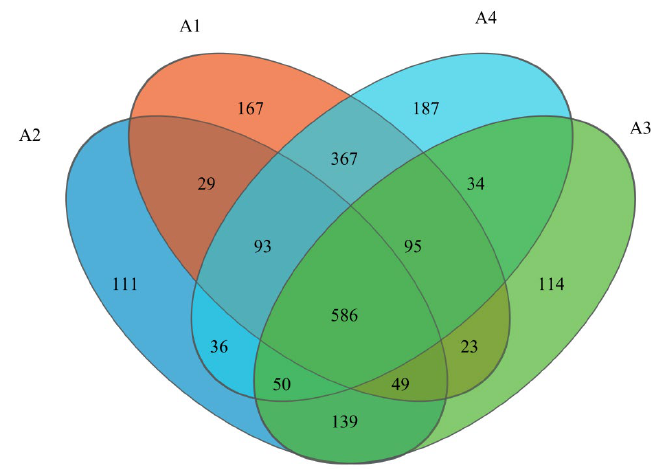
Figure 4. Venn diagram of different salinity concentrations.